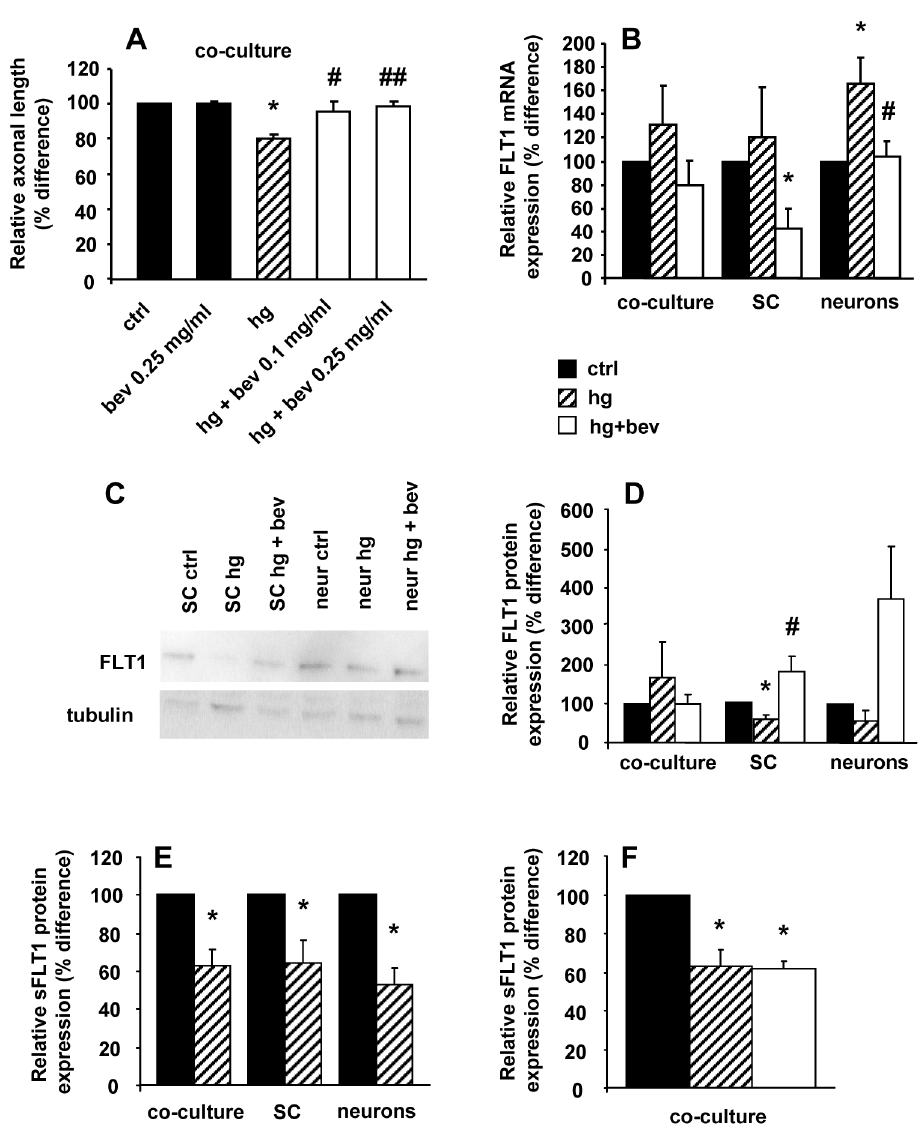
neurons monocultures ( n =5). (C) Representative and (D) quantitative western blot (WB) ( n =5) showing the significant decrease of FLT-1 in hyperglycaemia-conditioned SC monocultures and the preventive effect of bevacizumab. (E) sFLT-1 decreased in the medium of all neuron and SC monocultures and co-cultures exposed to hyperglycaemia ( n =5). (F) Bevacizumab did not affect sFLT-1 level in hyperglycaemia-conditioned co- cultures ( n =3). Data are expressed as mean 6 SEM of independent experiments. *p , 0.05 vs controls; # p , 0.05 vs hyperglycaemia; ## p , 0.01 vs hyperglycaemia.